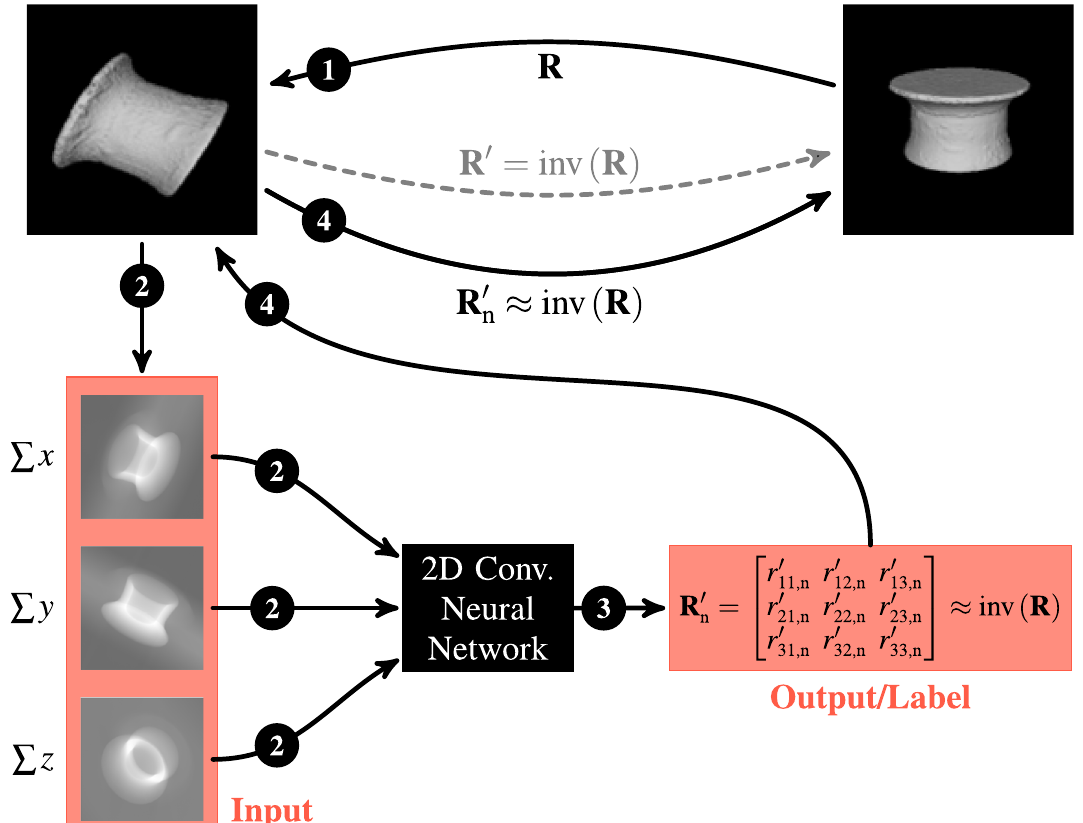
matrix based on the three projections. (4) The predicted rotation matrix is used to rotate the volume back to its original orientation. R ′ is the inverse rotation matrix or, respectively, the rotation matrix from our data set, which the network is supposed to learn. R ′ n is the resulting rotation matrix from the